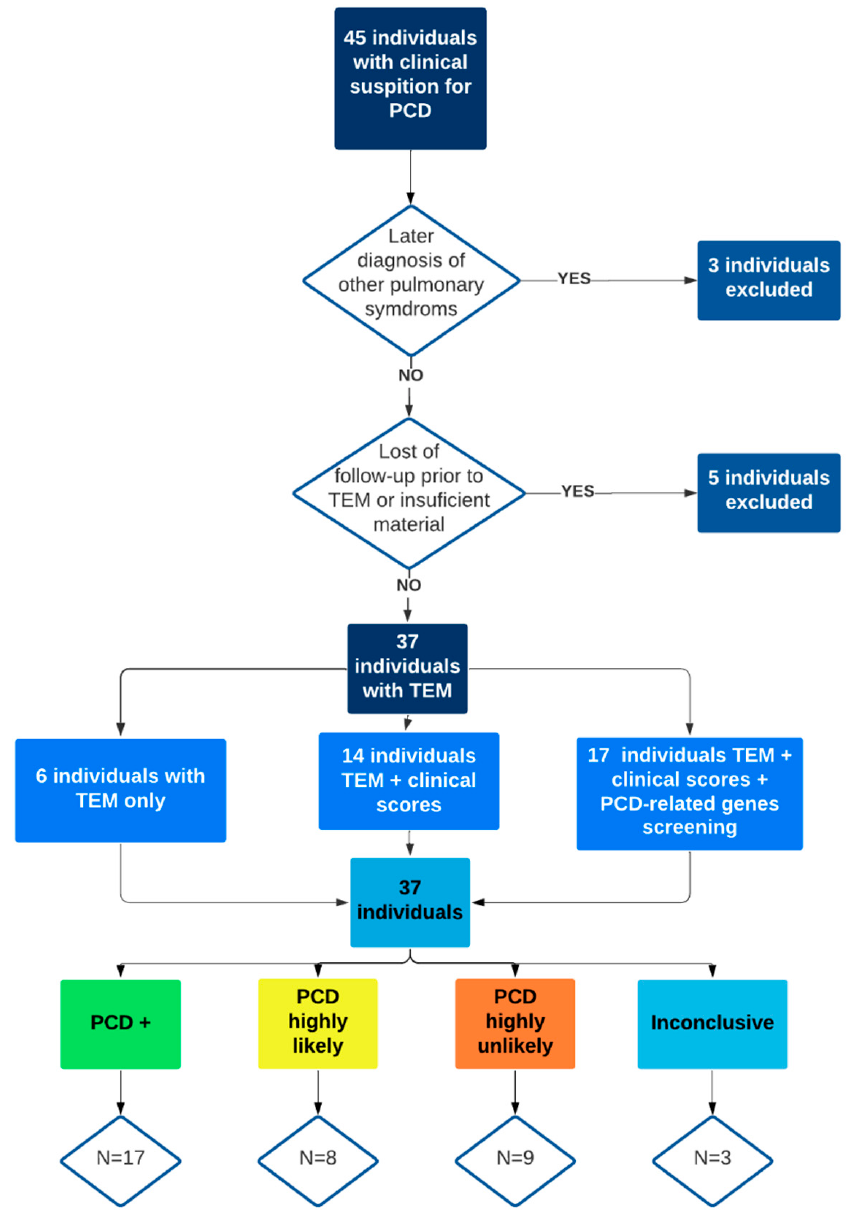
Figure 1. Included patients’ algorithm and division by the degree of clinical suspicion. PCD: primary ciliary dyskinesia, TEM: transmission electron microscopy, N: number of individuals.